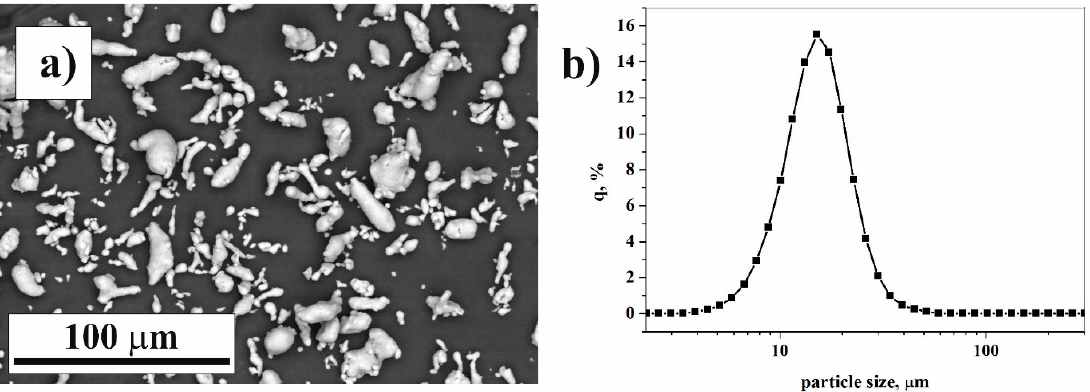
Figure 1. Scanning electron microscopic (SEM) image ( a ) and particle size distribution of the Al powder ( b ).